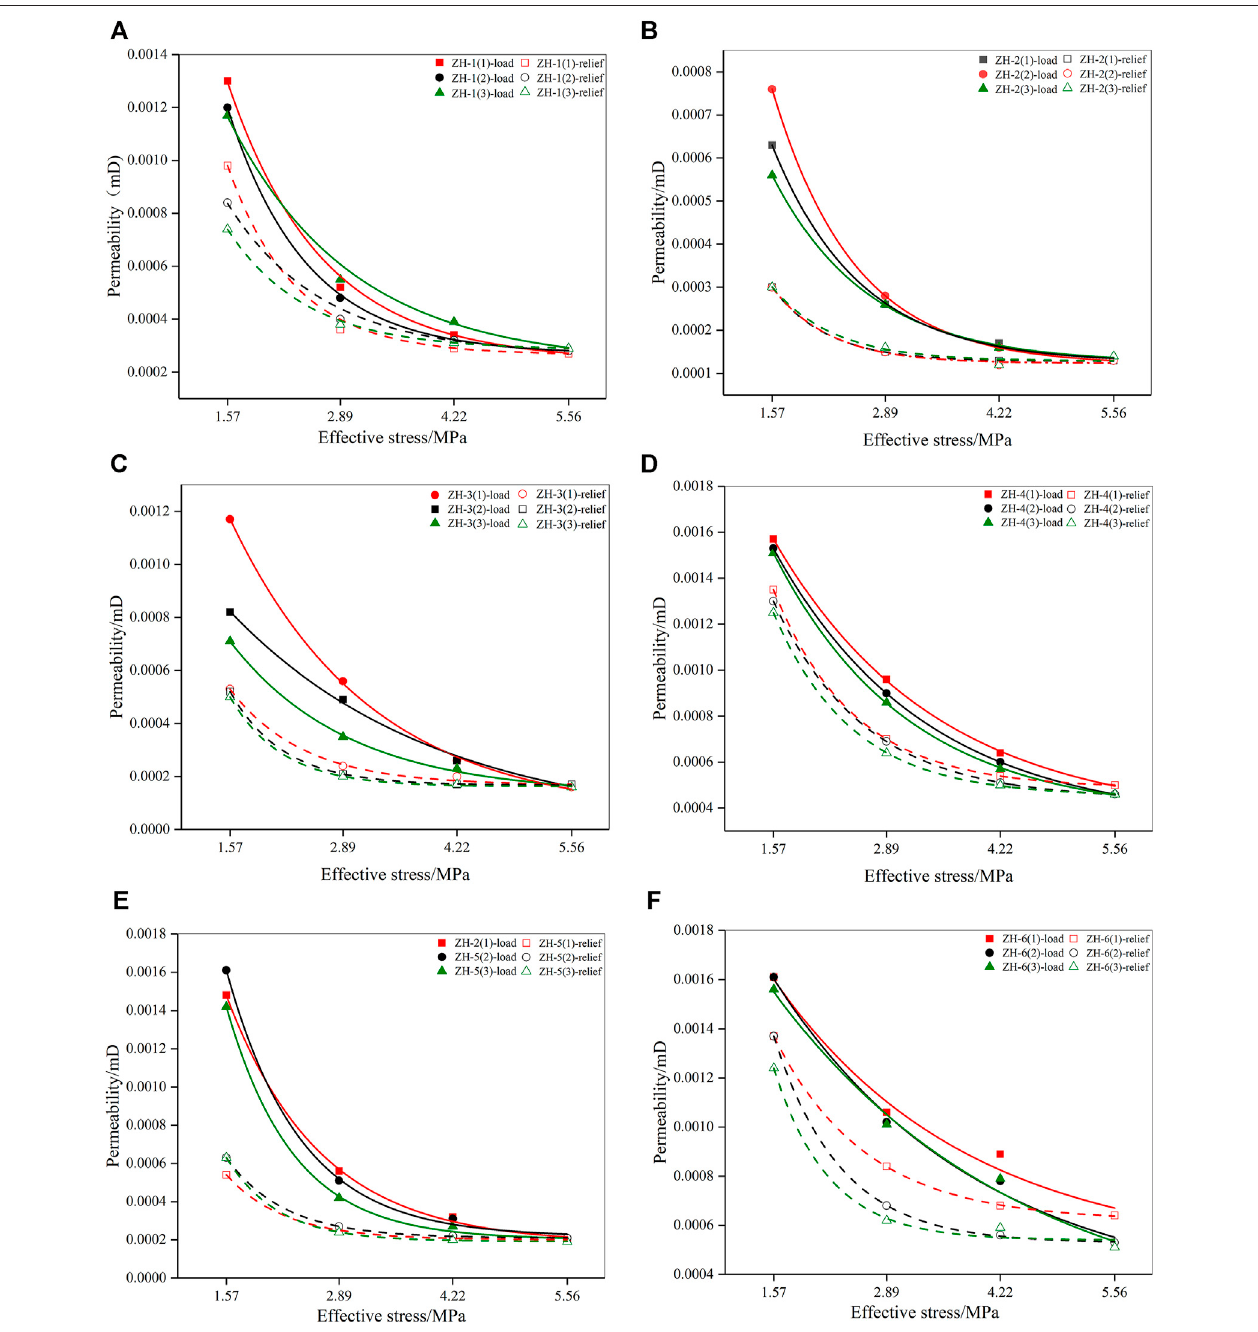
FIGURE 8 | The relationship between permeability and effective stress of 6 types of surrounding rock combinations. (A) -combination 1; (B) -combination 2; (C) -combination 3; (D) -combination 4; (E) -combination 5; (F) -combination 6.